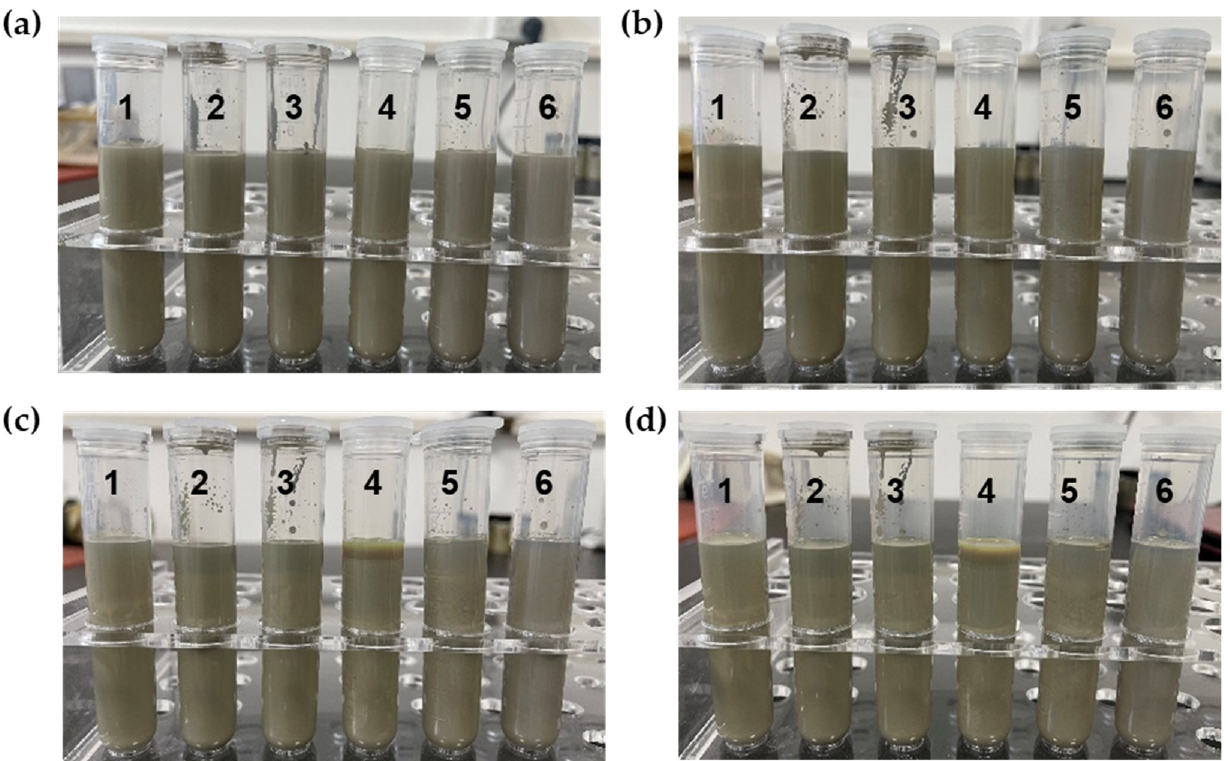
Figure 8. Storage stability of silver conductive ink (numbers 1–6 are 1030H-Ag-82%, 1030H-Ag-84%, 1030H-Ag-86%, 1030H-Ag-88%, 1030H-Ag-90%, and 1030H-Ag-92%, respectively). ( a ) 1d; ( b ) 30d; ( c ) 45d; ( d ) 60d.